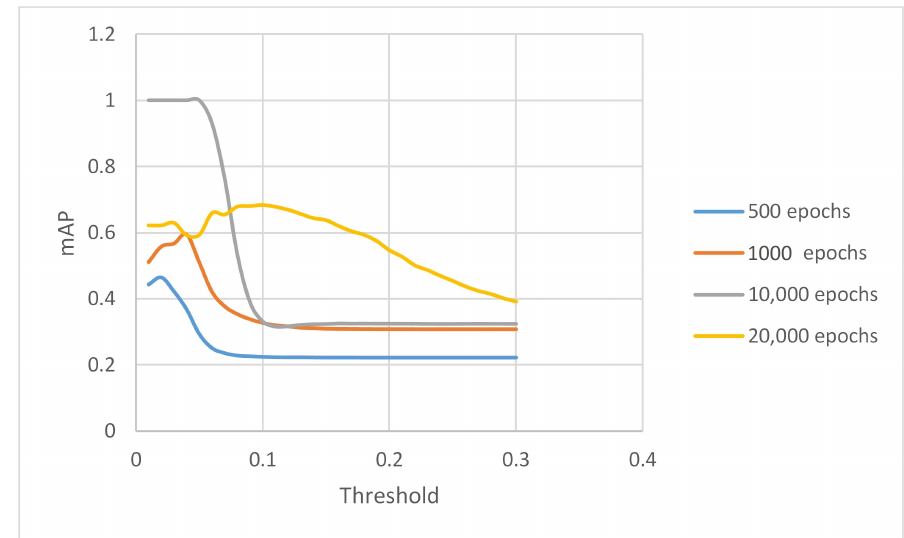
Figure 12. mAP evolution according to the threshold. This test was performed for several sets of weights.